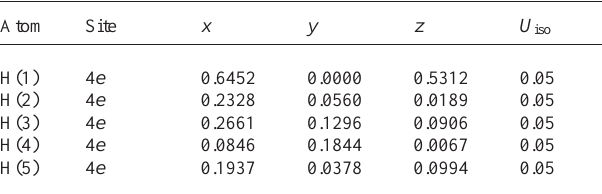
Table 2. Atomic coordinates and displacement parameters (in Å 2 )